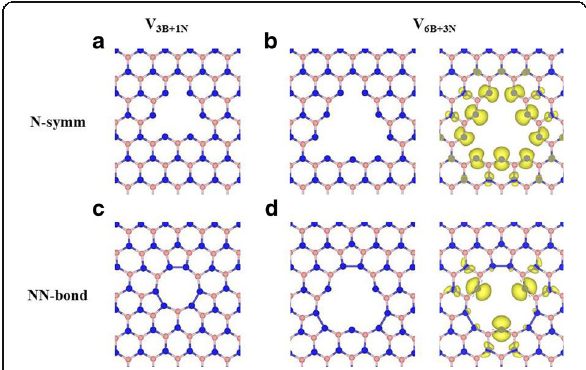
Fig. 1 Optimized vacancy structures of a V 3B+1N and b V 6B+3N with N- symm structure and c V 3B+1N and d V 6B+3N with NN-bond structure. Blue and pink balls represent B and N atoms, respectively. Beside plots b and d are the differences in the spin density projected on the plane of the V 6B+3N